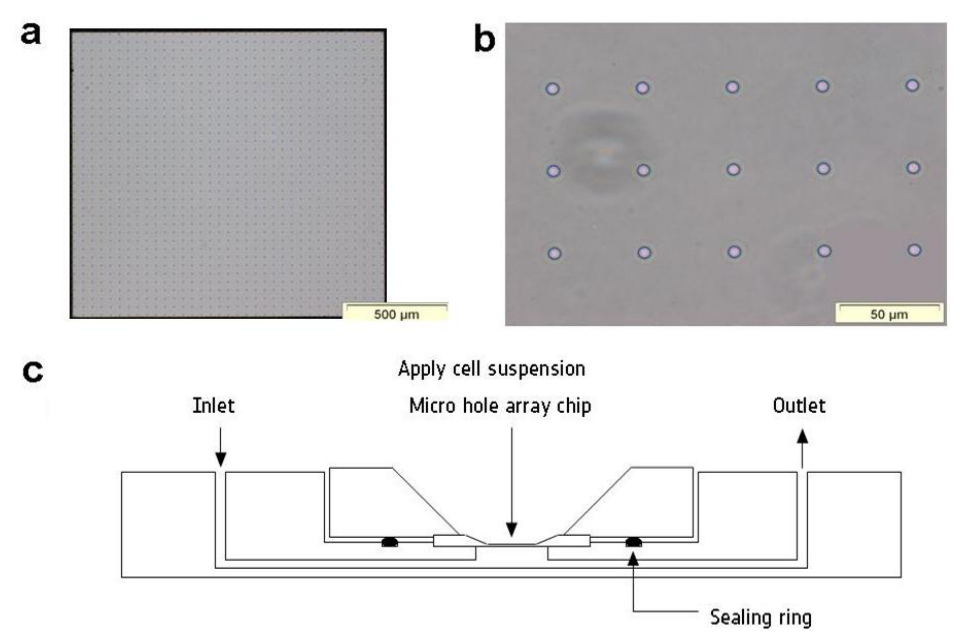
Figure 1. ( a , b ) Phase-contrast images of the empty membrane with different magnification. 35 × 35 holes, holes size: 5 µm, hole pitch (spacing): 40 µm; Si